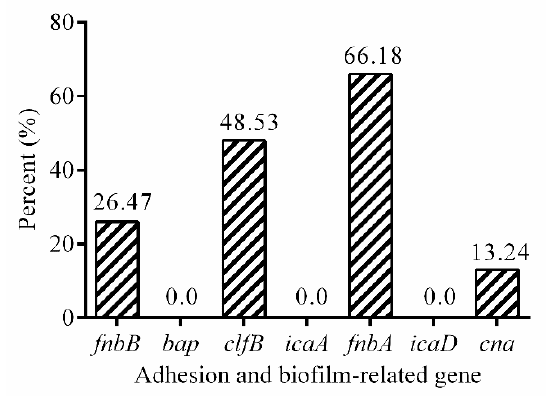
Figure 2. The prevalence of adhesion and biofilm-related genes in 68 isolates.